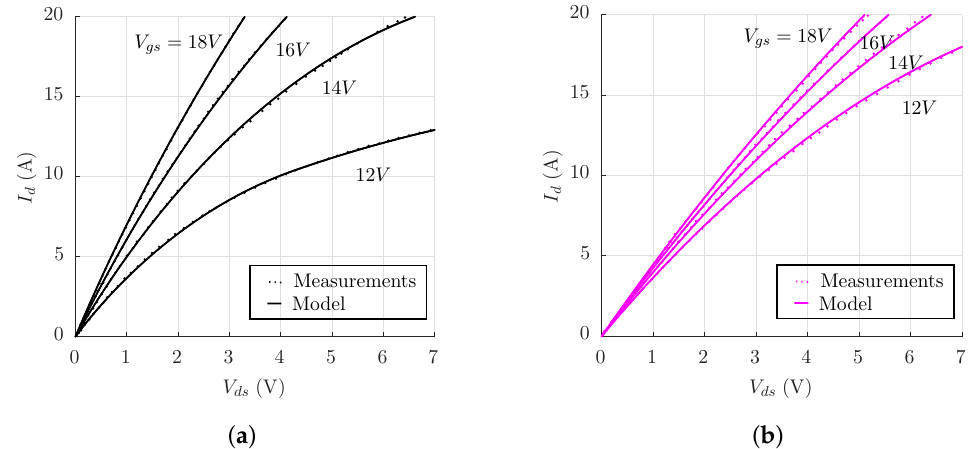
Figure 2. Simulated model and measured IV -characteristics for 1200 V SiC MOSFET at ( a ) 25 ◦ C and ( b ) 150 ◦ C.